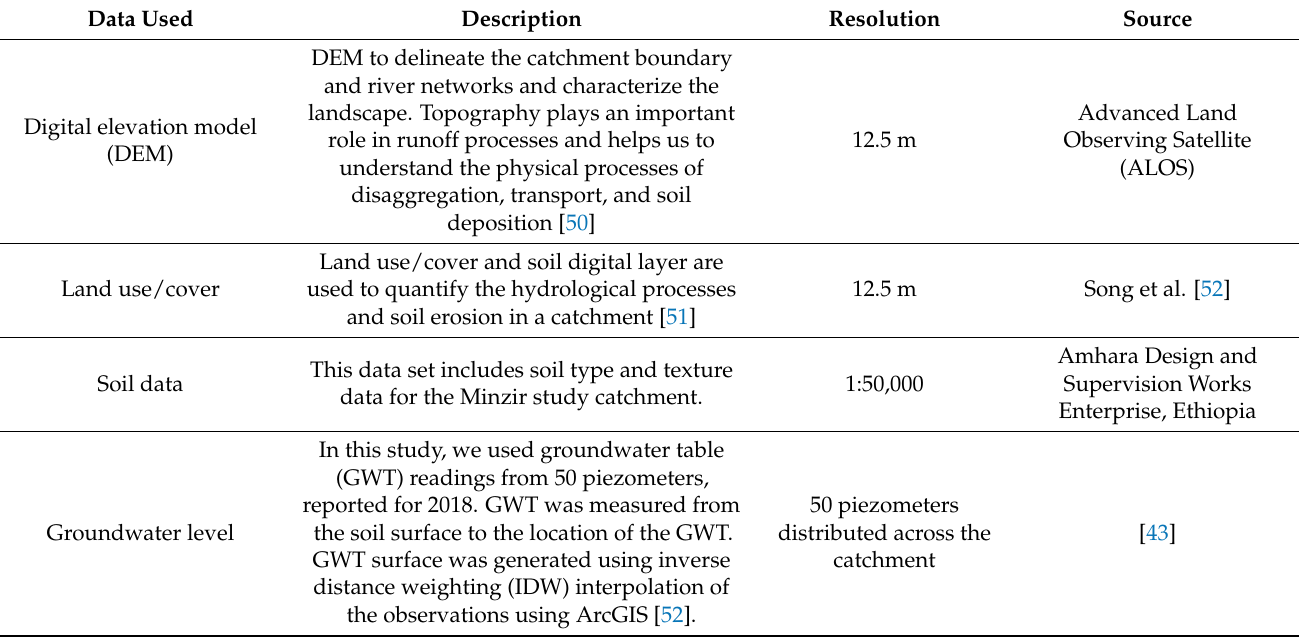
Table 1. Data sources.